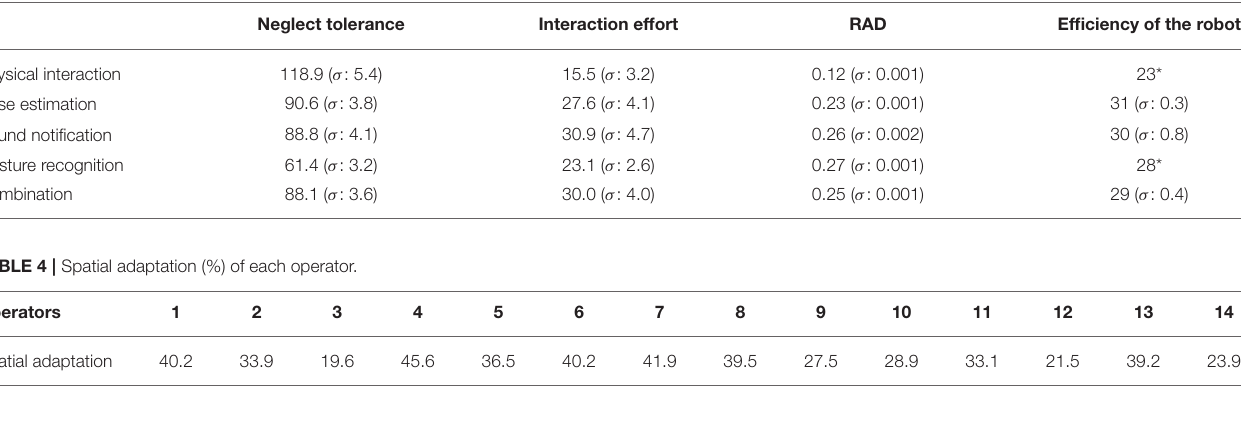
TABLE 3 | Average of HRC metrics for each experiment. Neglect Tolerance (s), Interaction effort (s), Robot Attention Demand (RAD), and Efficiency of the robot(%) (*no spatial adaptation).